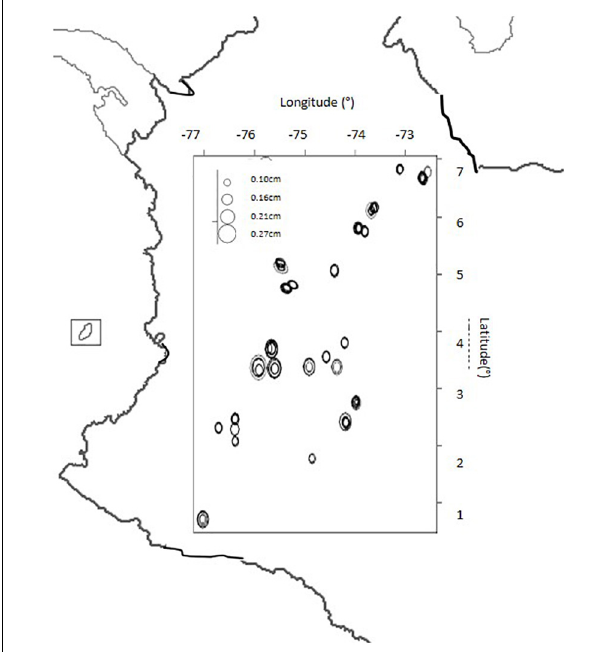
FIGURE 4 | Seed size (in cm) distribution for landrace genotypes of purple passion fruit, Passiflora edulis Sims. F. edulis , collected from Colombia based on geographical collection site with latitude and longitude numbers (in degrees) given to the top and right of the boxed